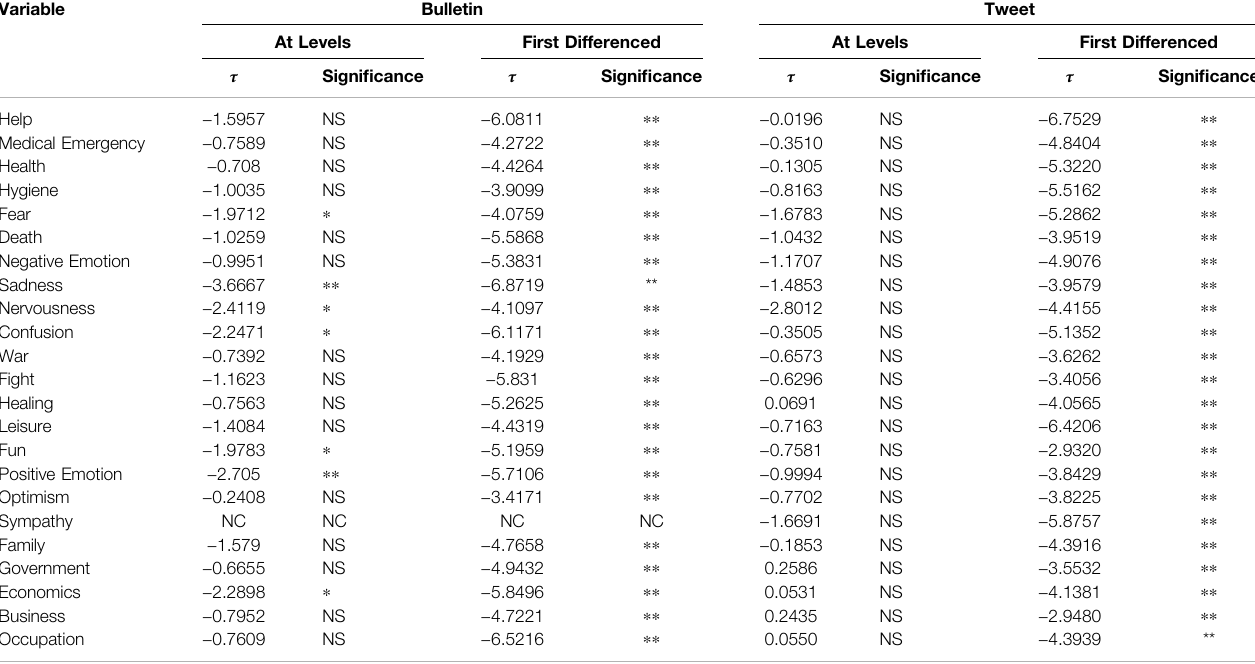
TABLE 5 | Results in respect of Augmented Dickey – Fuller test of Unit Root.